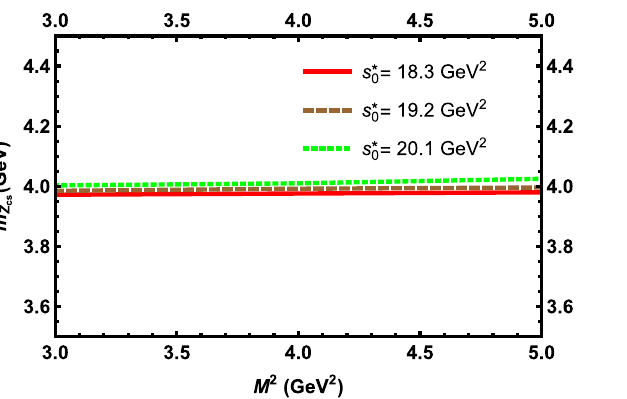
Fig. 2 The vacuum current coupling of Z cs state as function of M 2 at different fixed values of continuum